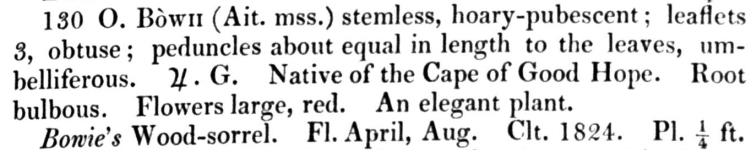
The original description of Oxalisbowiei W.T.Aiton ex G.Don from A general history of the dichlamydeous plants by George Don. Taken from the Biodiversity Heritage Library https://biodiversitylibrary.org/page/390566 (Don 1831).